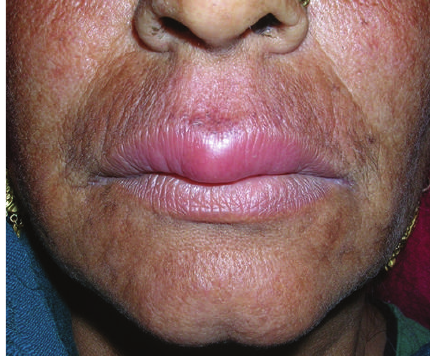
Figure 5: Posttreatment photograph of the second patient after 1